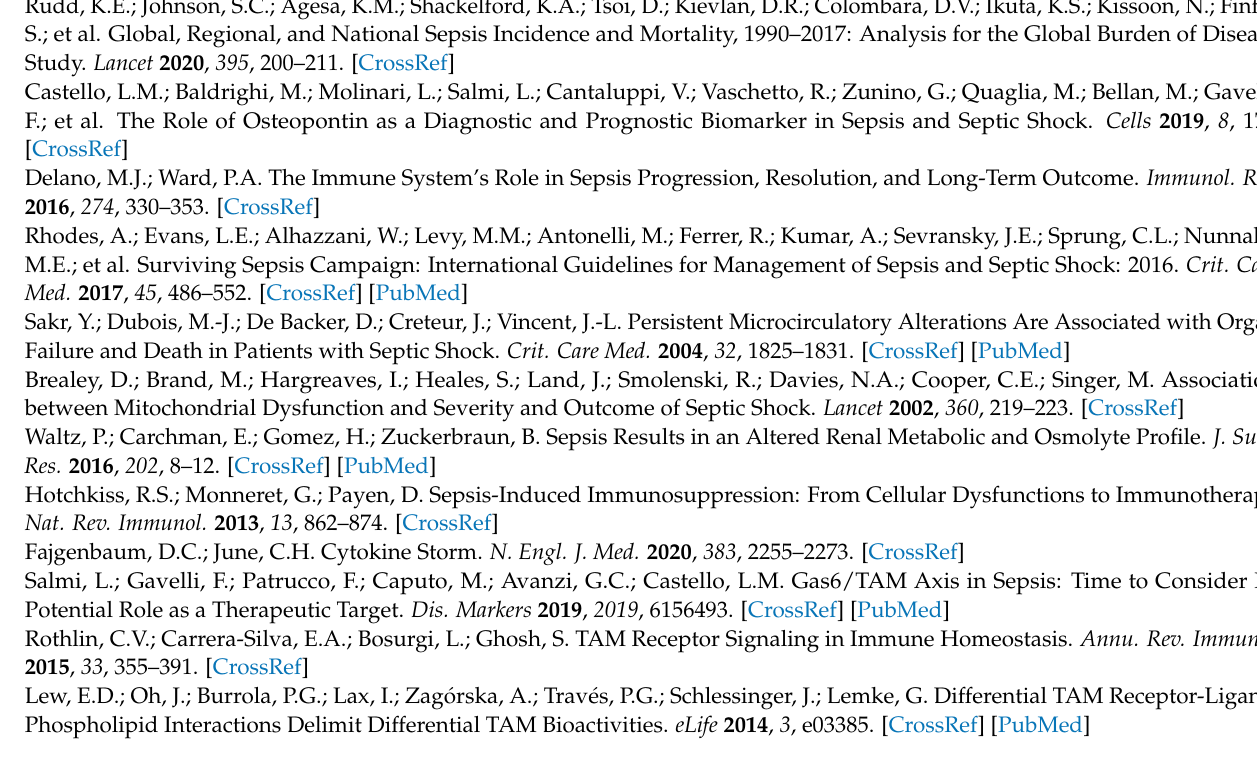
Figure S2. Liver histology with hematoxylin-eosin (H&E) staining. Figure S3. Kidney (a) and lung (b) histology with hematoxylin-eosin (H&E) staining for control mice. Figure S4. Organ function of control mice. Figure S5. In vitro control treatments. Figure S6. Representative fluorescent images of reactive oxygen species (ROS). Figure S7. Relative expression (2 − ∆ Ct ) of cytokines measured in liver, kidney and lung